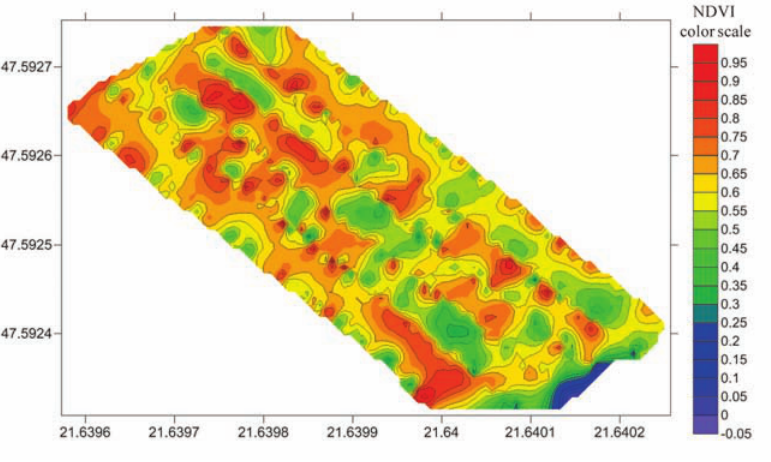
Figure 1: NDVI vegetation map of the hail protection net apple orchard